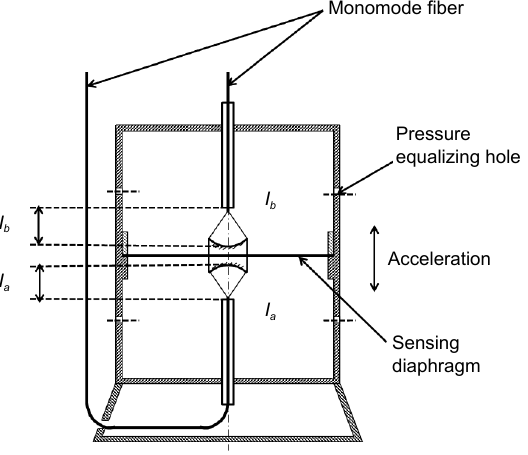
Fig. 19 | Schematic of a Fabry-Perot cavity based accelerometer head. Figure reproduced with permission from ref. 86 , Optical Society of America.